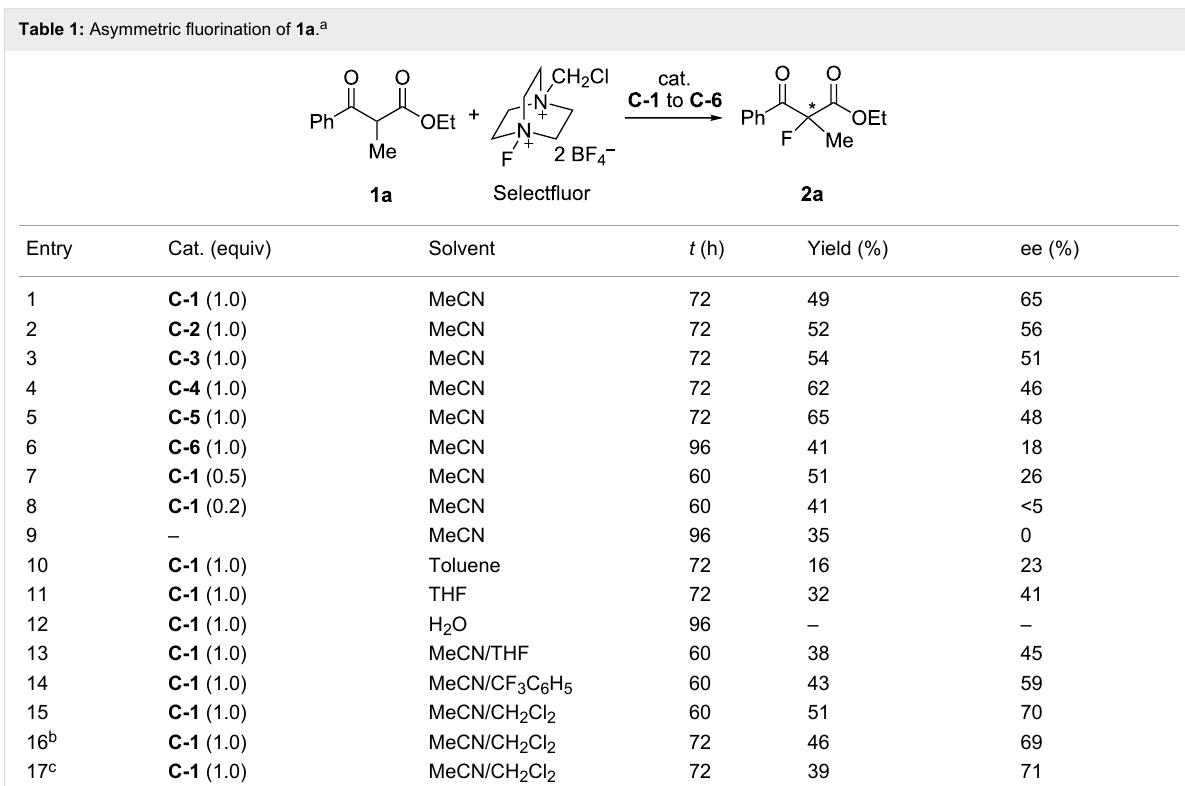
Table 1: Asymmetric fluorination of 1a .